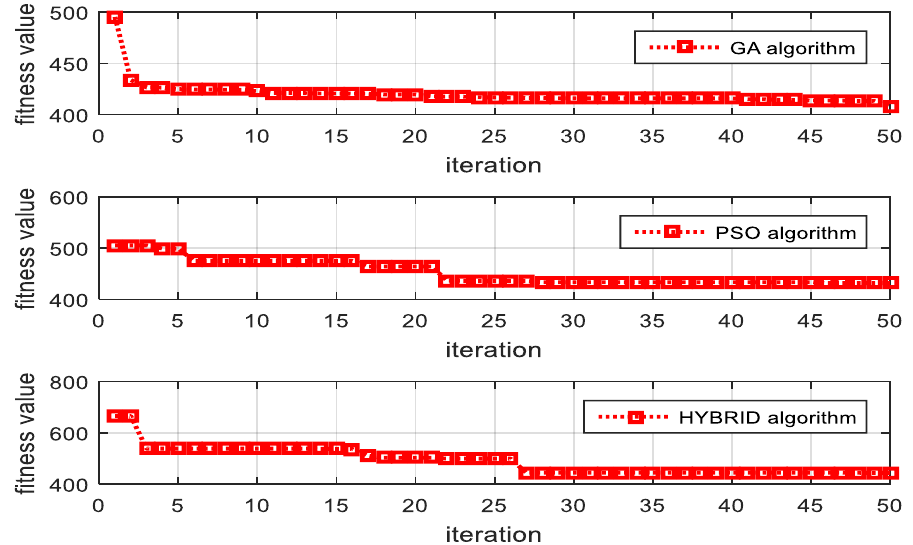
Figure 7. Fitness function for GA, PSO and hybrid optimization technique using PEM based method for scenario-2.